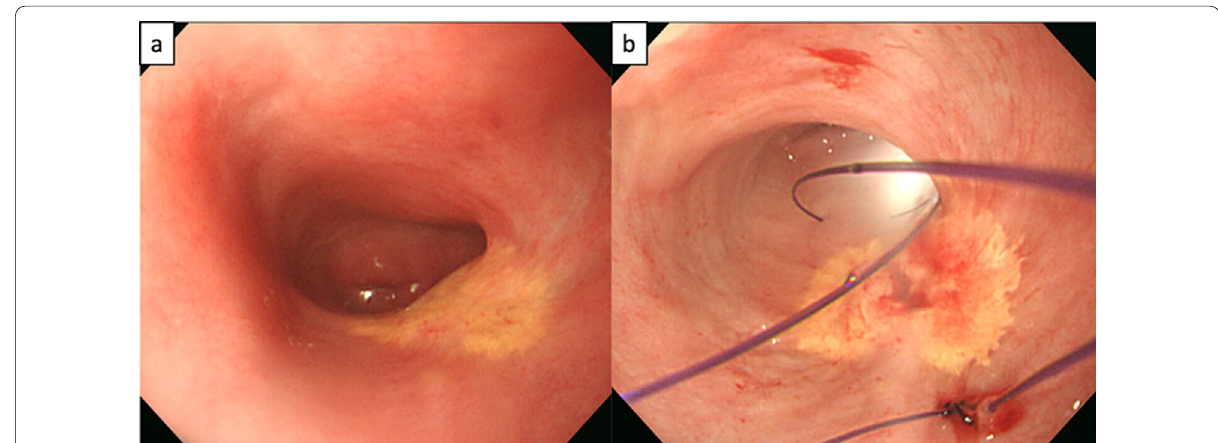
Fig. 4 Endoscopic imaging of the vagina at the radical surgery. a Yellowish tumor resides on the left posterolateral wall of the vagina. b Marked sutures at the proximal and distal ends of the tumor. Light from the laparoscope is seen through the distal end of the vaginal wall